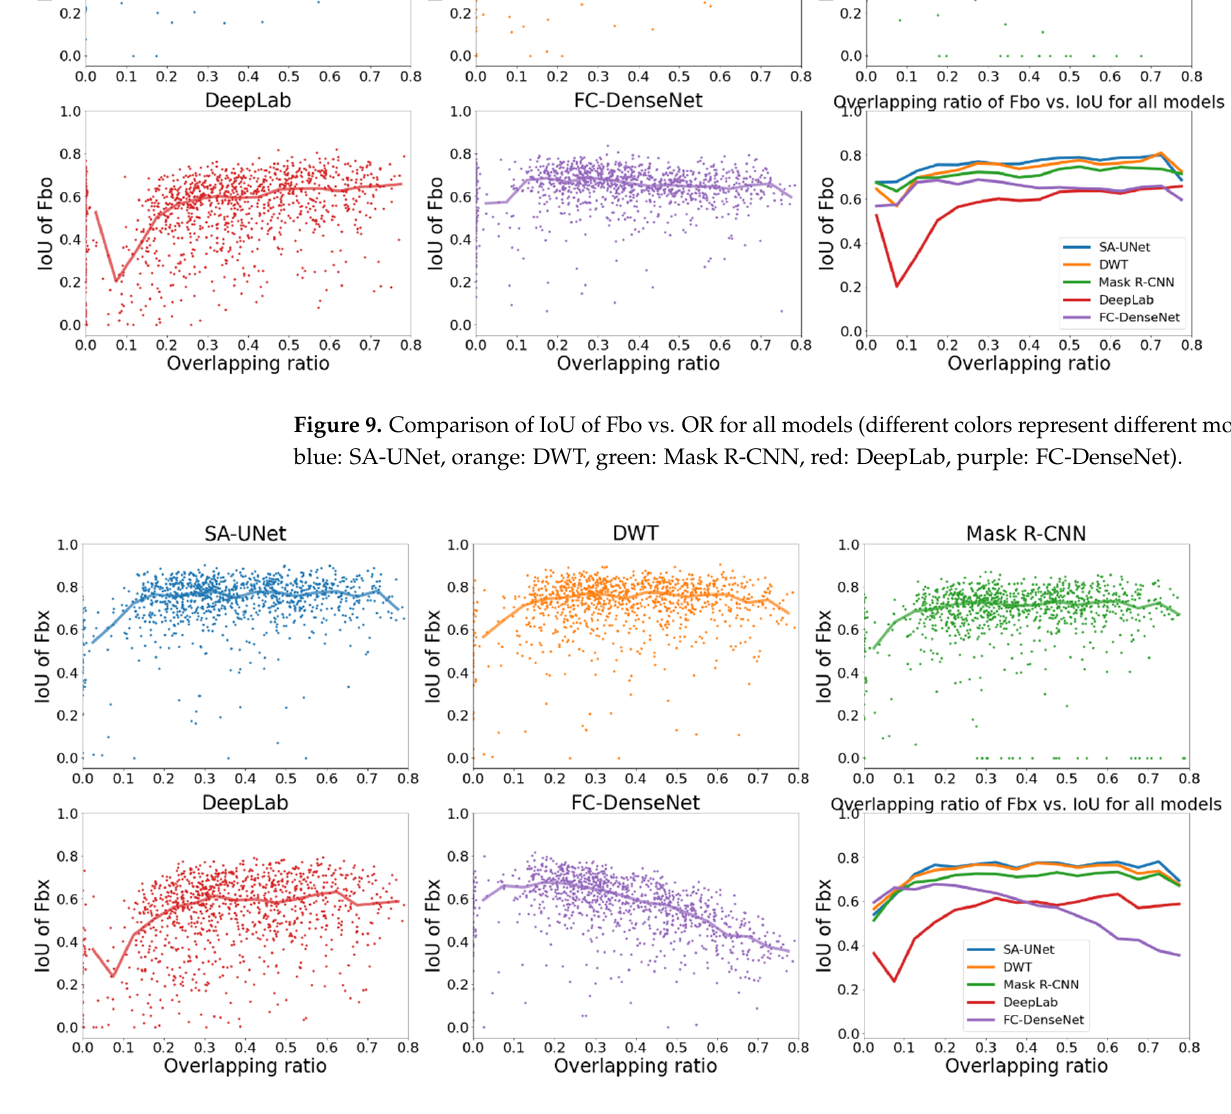
Figure 10. Comparison of IoU of Fbx vs. OR for all models (different colors represent different models: blue: SA-UNet, orange: DWT, green: Mask R-CNN, red: DeepLab, purple: FC-DenseNet).